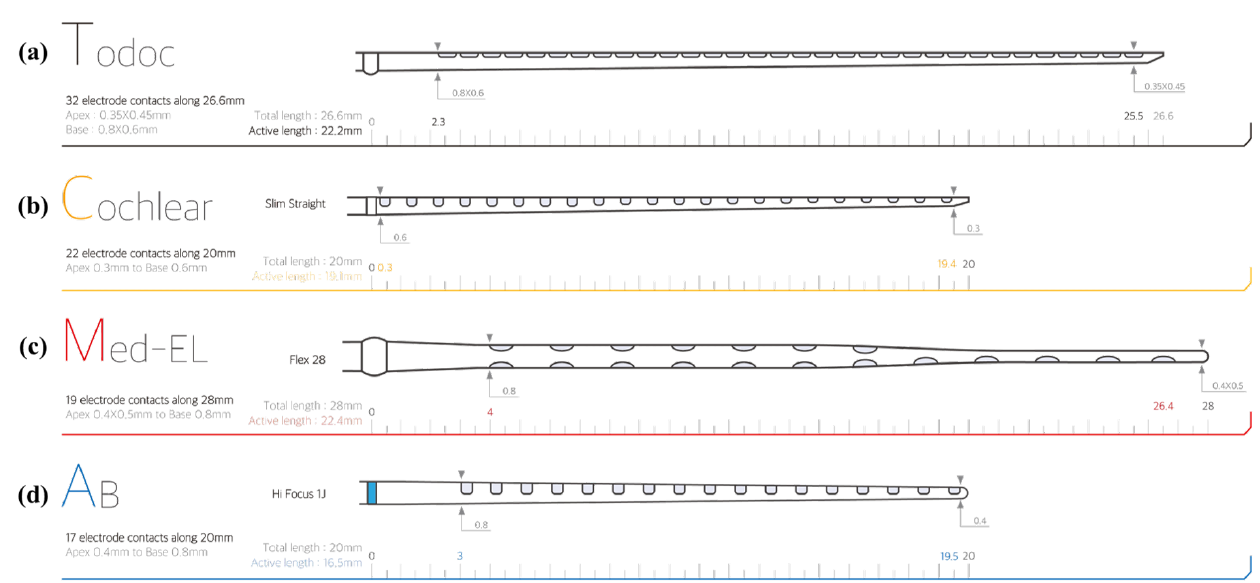
Figure 7. Comparison of Commercial CI Electrode Arrays: ( a ) TODOC Co., Ltd.; ( b ) Cochlear Ltd.; ( c ) Med-El; and ( d ) Advanced